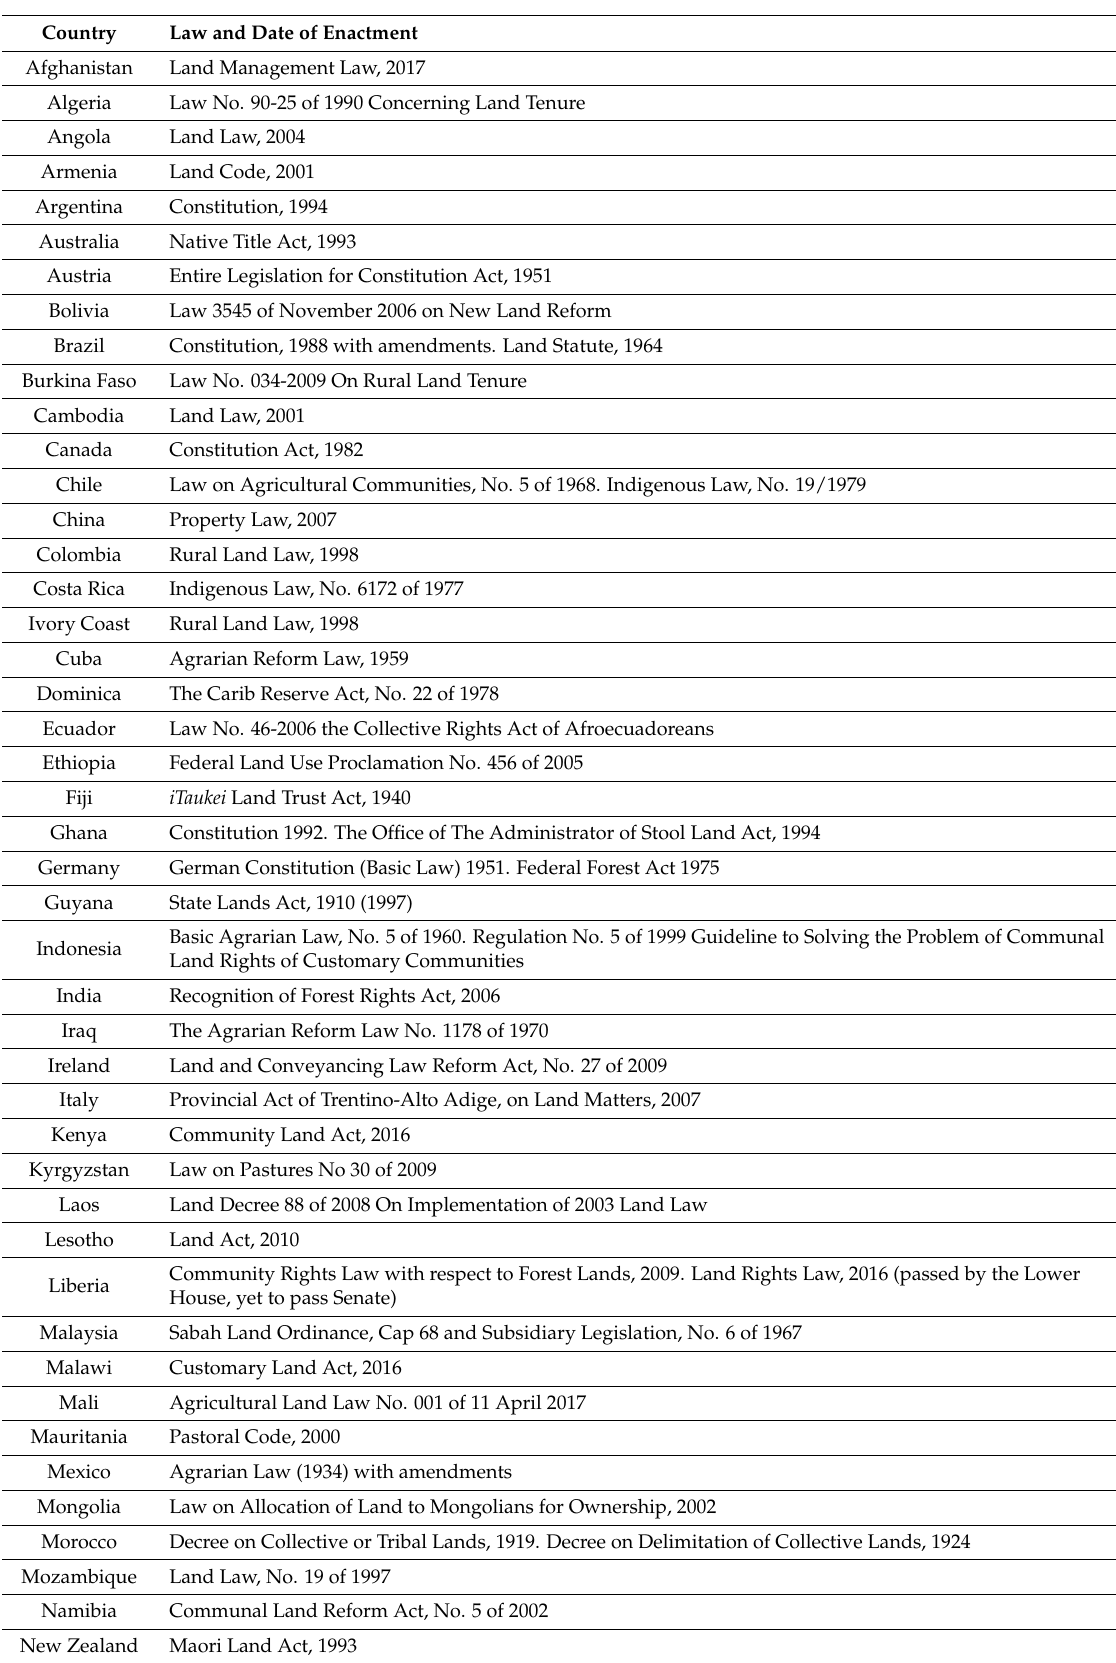
Table 5. Principal law recognizing community property in 73